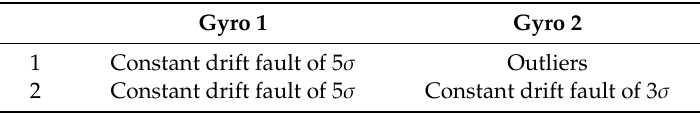
Table 5. The scheme of anomaly